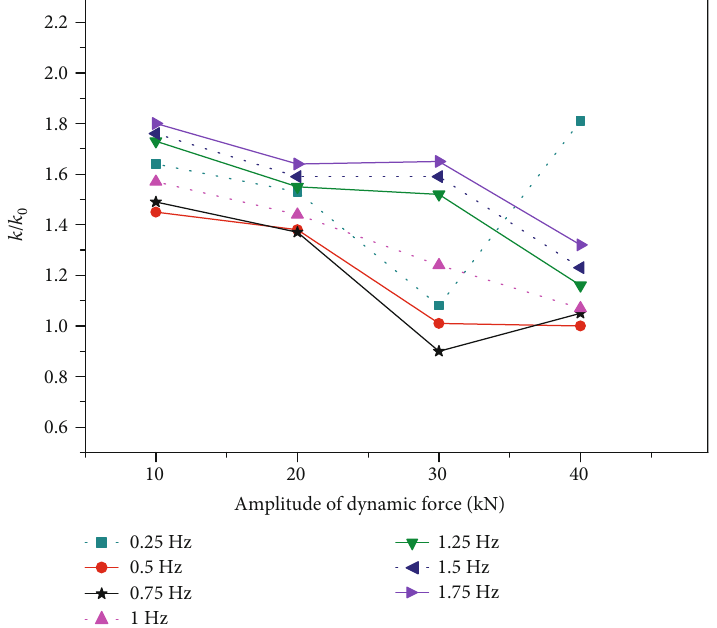
Figure 8: Permeability evolution of fracture in di ff erent amplitudes of dynamic normal force under